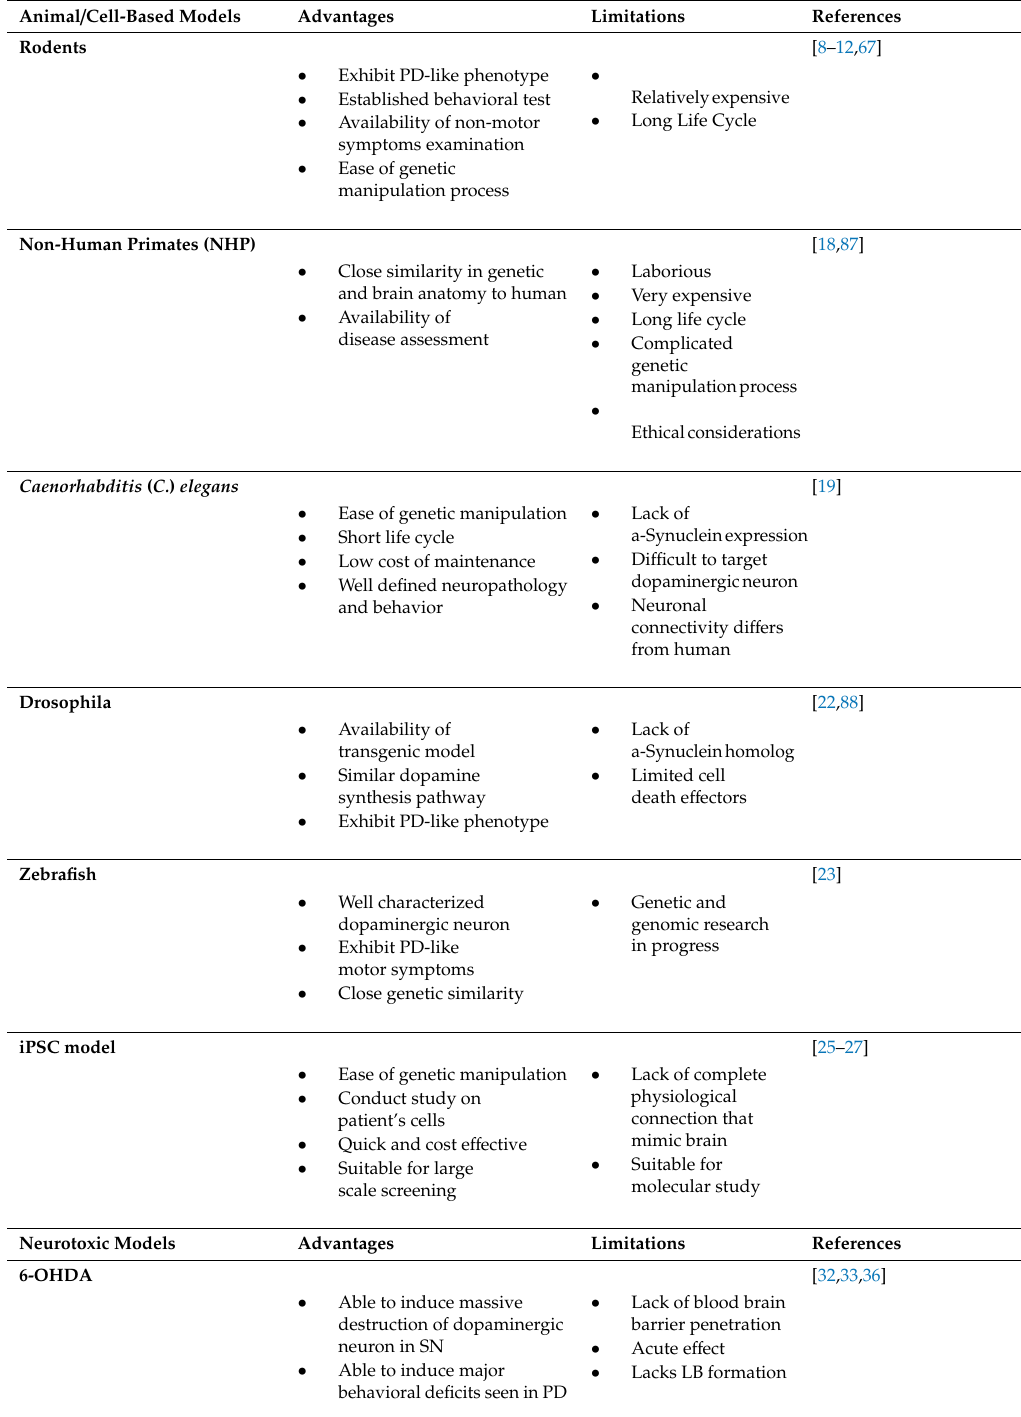
Table 1. Summary of the advantages and limitations of animal model, neurotoxic model, and genetic model in Parkinson’s Disease